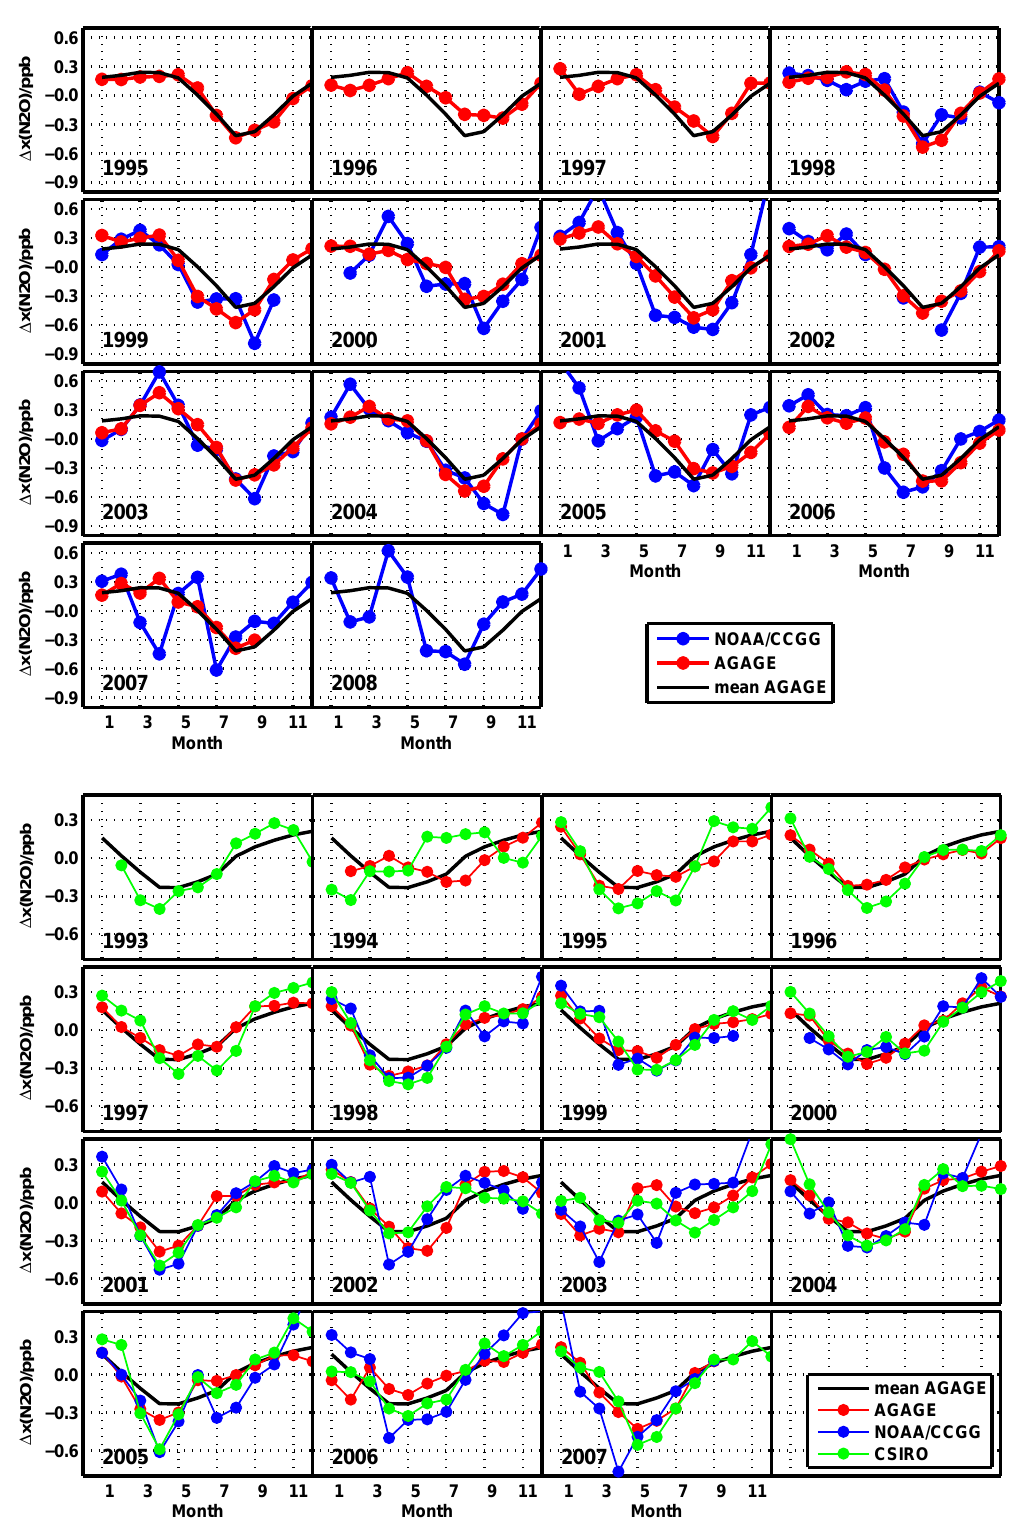
Fig. 1. (a) Monthly mean detrended N 2 O residuals from AGAGE and NOAA/CCGG networks at Mace Head, Ireland. (b) Monthly mean detrended N 2 O residuals from AGAGE, NOAA/CCGG and CSIRO networks at Cape Grim, Tasmania.